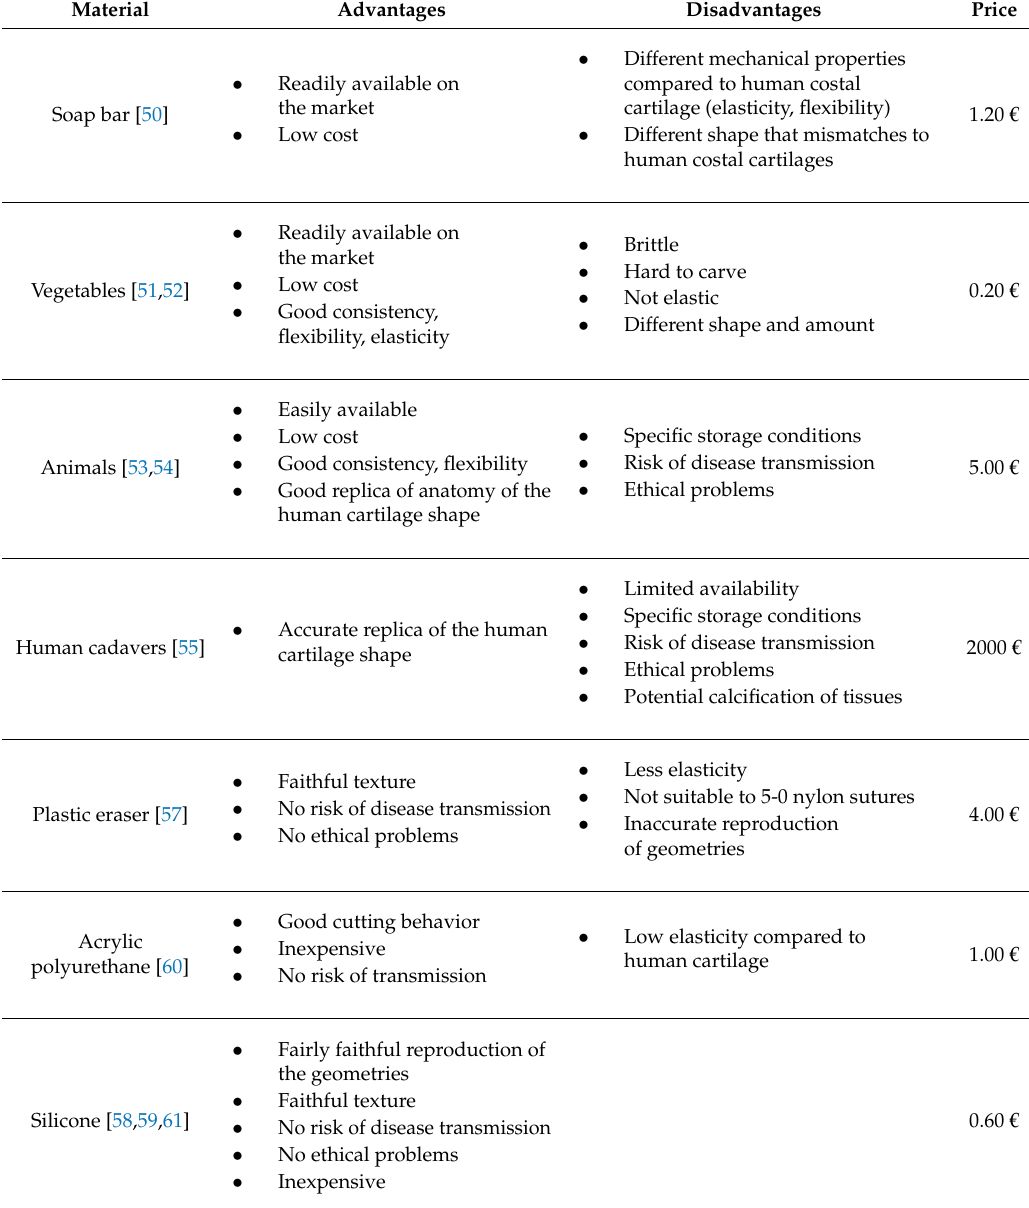
Table 1. Advantages and disadvantages of the materials used to resemble human costal